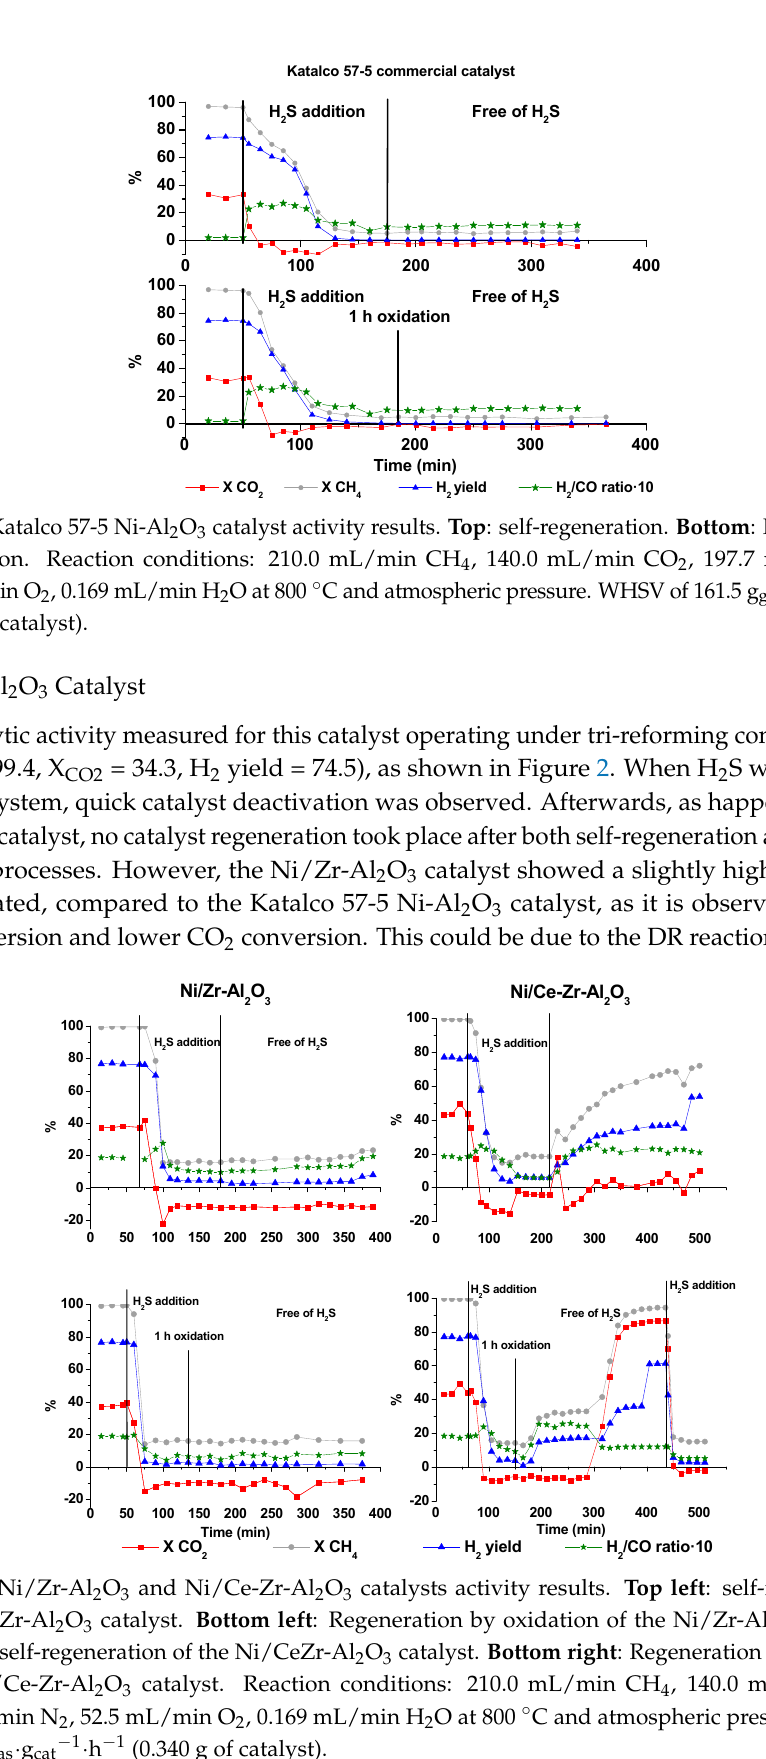
Figure 2. Ni/Zr-Al 2 O 3 and Ni/Ce-Zr-Al 2 O 3 catalysts activity results. Top left : self-regeneration of the Ni/Zr-Al 2 O 3 catalyst. Bottom left : Regeneration by oxidation of the Ni/Zr-Al 2 O 3 catalyst. Top right : self-regeneration of the Ni/CeZr-Al 2 O 3 catalyst. Bottom right : Regeneration by oxidation of the Ni/Ce-Zr-Al 2 O 3 catalyst. Reaction conditions: 210.0 mL/min CH 4 , 140.0 mL/min CO 2 , 197.7 mL/min N 2 , 52.5 mL/min O 2 , 0.169 mL/min H 2 O at 800 °C and atmospheric pressure. WHSV of 161.5 g gas ·g cat − 1 · h − 1 (0.340 g of catalyst).